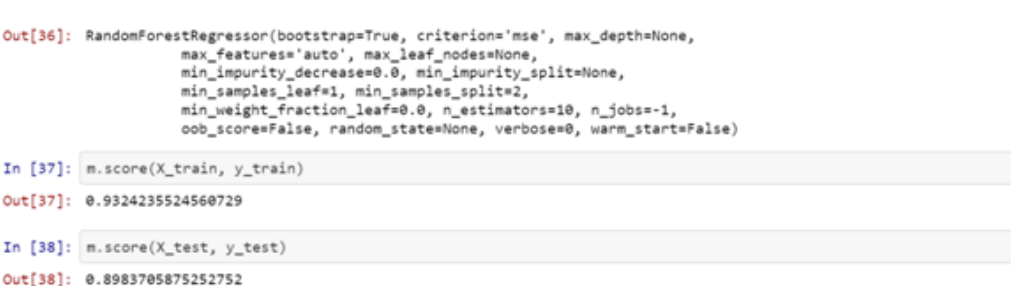
Figure A4. Summarized algorithm report - Excerpt